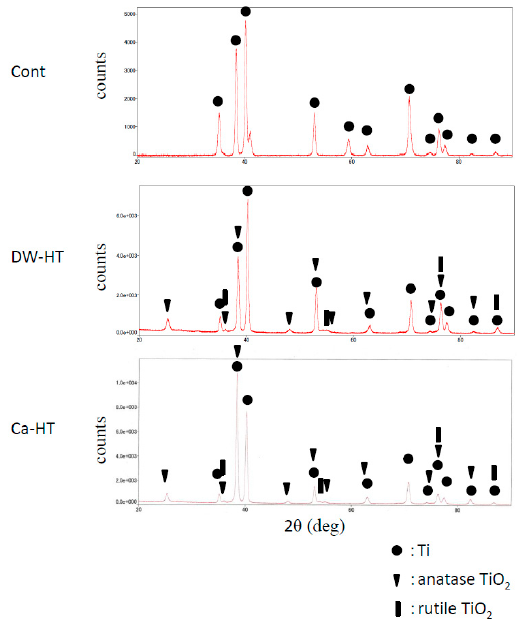
Figure 4. TF-XRD patterns of Cont, DW-HT and Ca-HT. TiO 2 peaks were indicated in both HT groups.